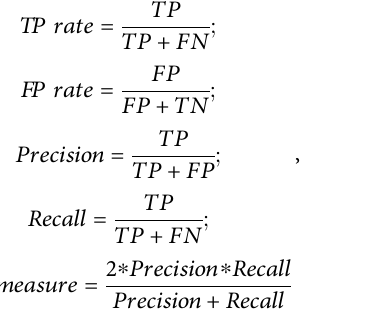
Frontiers in Genetics |